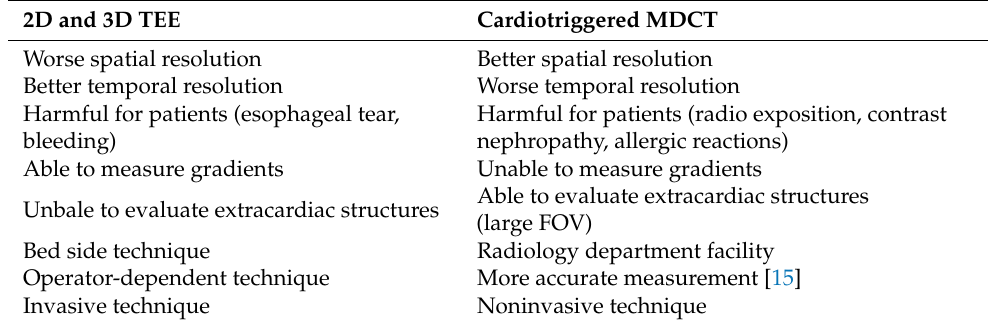
Table 1. Comparison between the TEE and MDCT techniques (advantages and